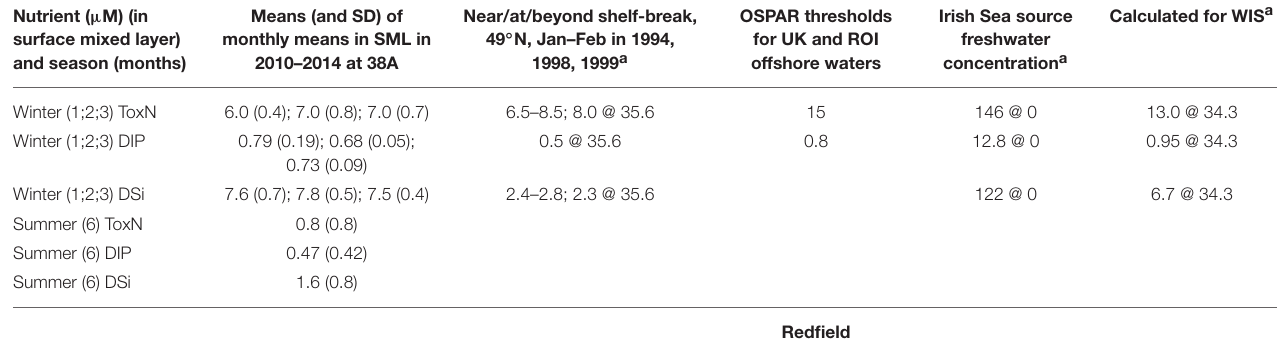
Irish Sea source Calculated for WIS freshwater concentration a